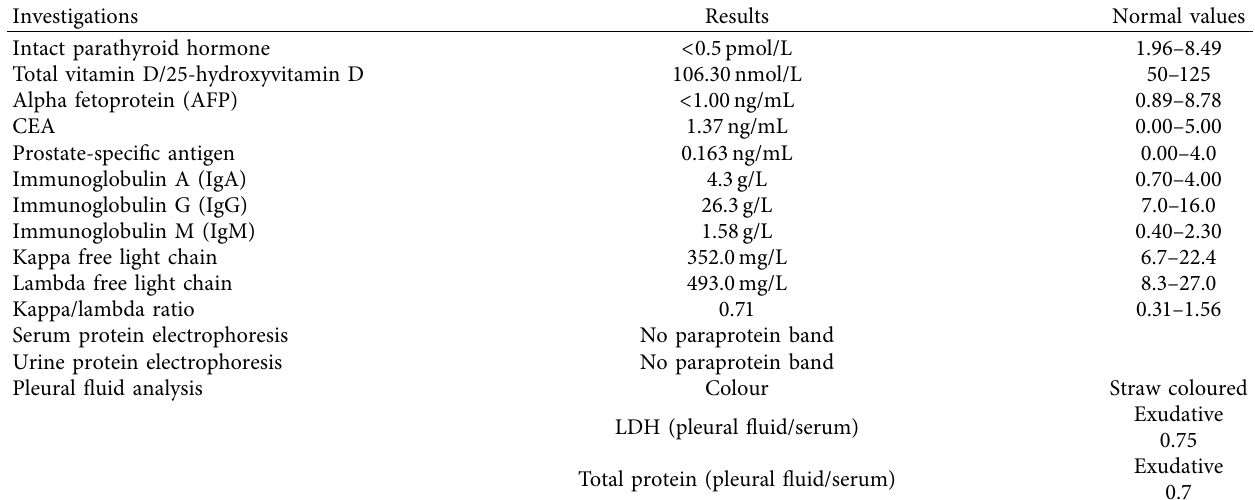
Table 2: Further blood samples sent for investigation of hypercalcemia.